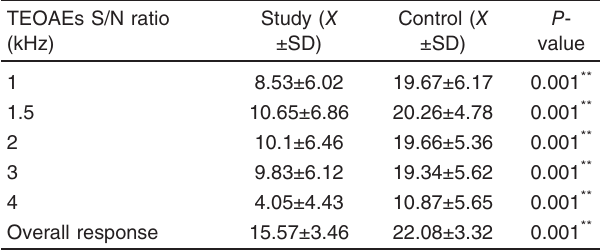
Table 6 Results of transient evoked otoacoustic emissions in both the study and control groups